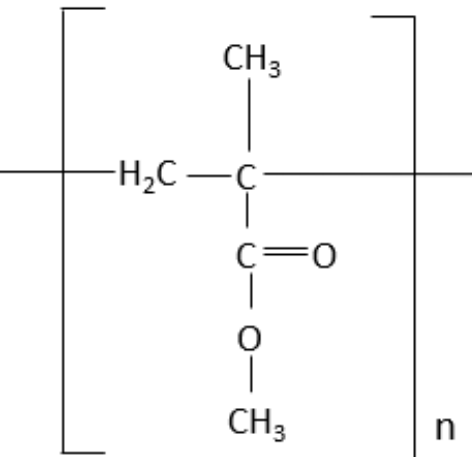
Figure 1. The structure of PMMA.